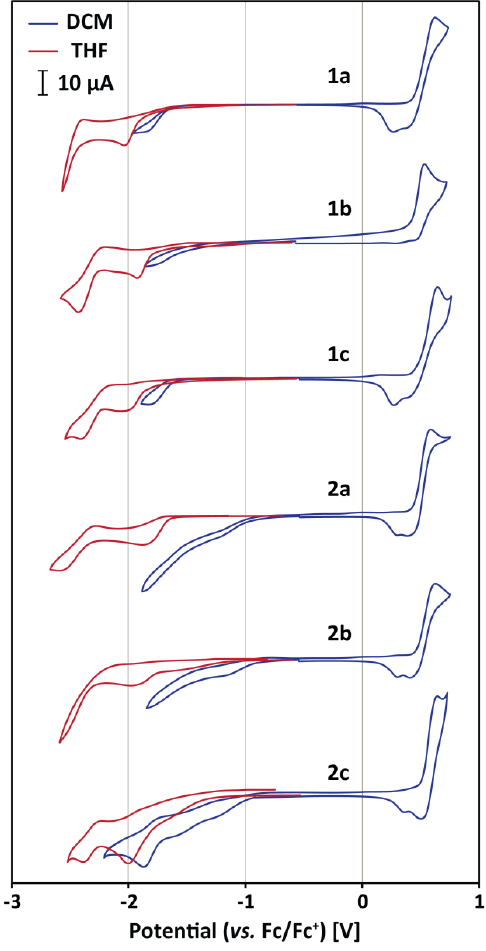
Figure 3. Cyclic voltammetry of 2 × 10 −3 M solutions of the studied compounds in DCM/(n-Bu) 4 NPF 6 (blue curves) and THF/(n-Bu) 4 NPF 6 (red curves); scan rate 0.1 V/s.